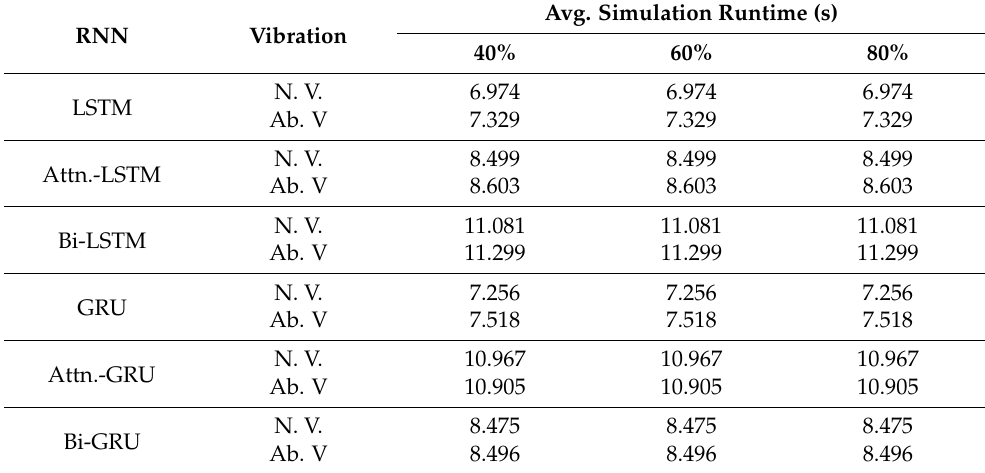
Table 5. Average simulation runtime for each RNN model for different segments of training data (60%, 40%,